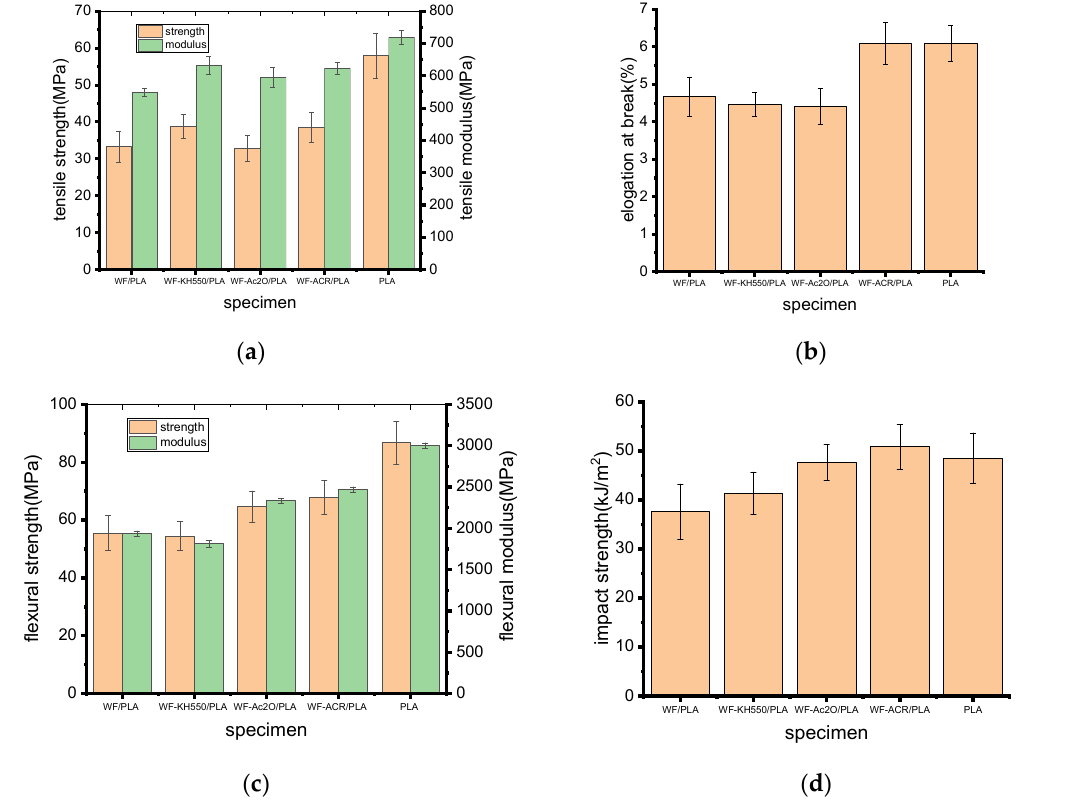
Figure 3. Mechanical properties of the printed materials: ( a ) tensile strength and modulus; ( b ) elon- gation at break; ( c ) flexural strength and modulus; ( d ) impact strength.